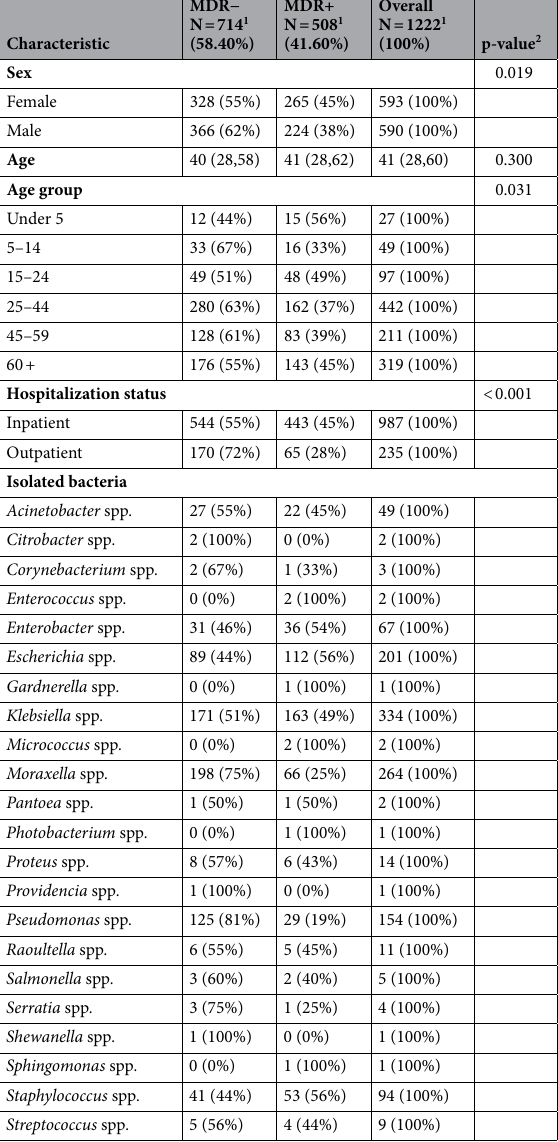
Table 4. Bivariate distribution of patient characteristics according to their multidrug resistance status. 1 n